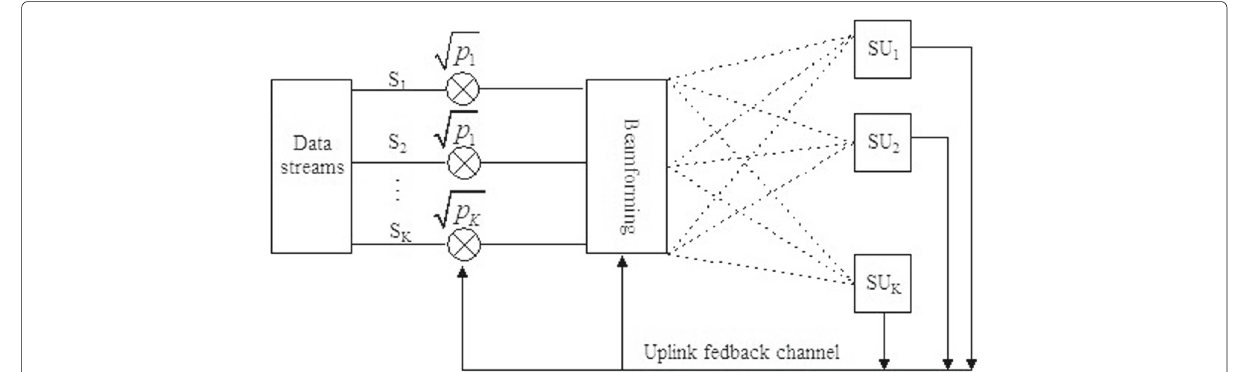
Fig. 2 Block diagram of BC-MAC duality relationship for the transmission process